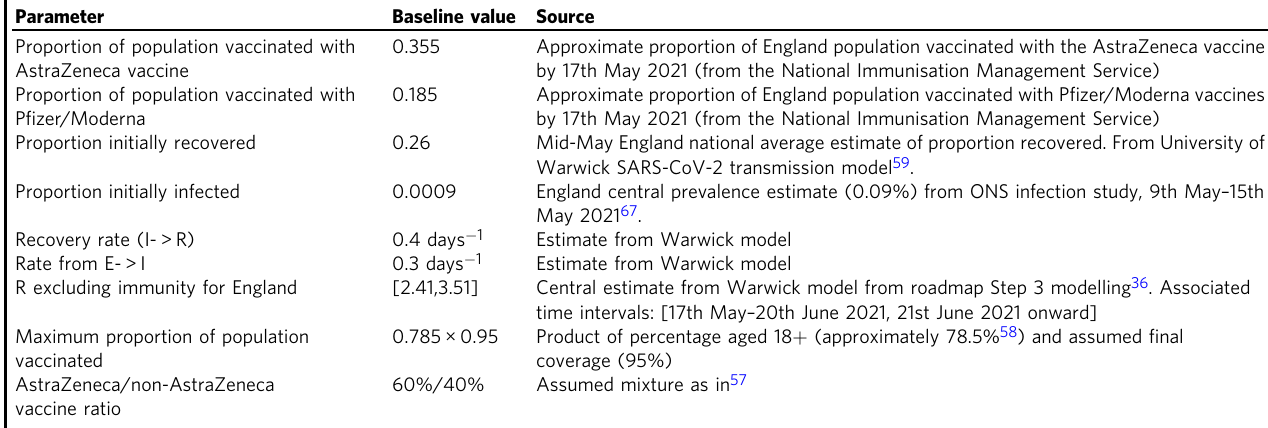
Table 2 Initial conditions, epidemiological and vaccination parameter assumptions for the parsimonious SARS-CoV-2 transmission